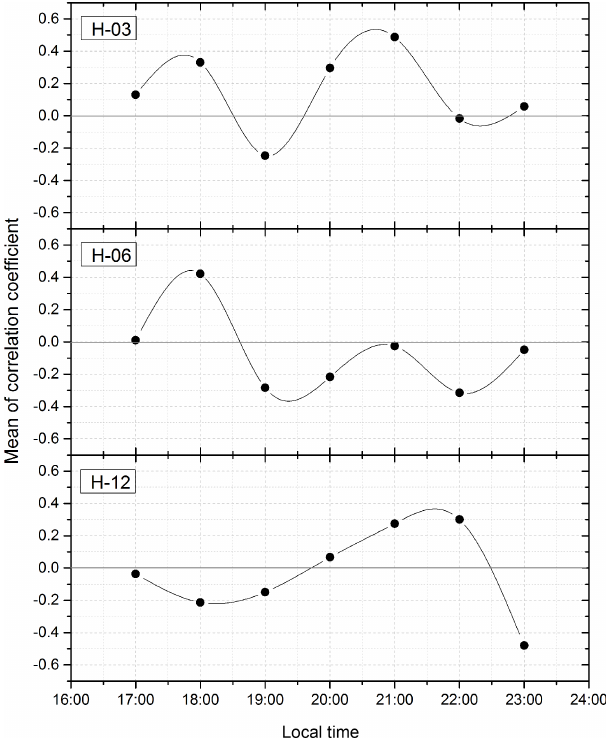
Figure 5. Correlation analysis between E y and (cid:49) hm F2 for the range from 17 to